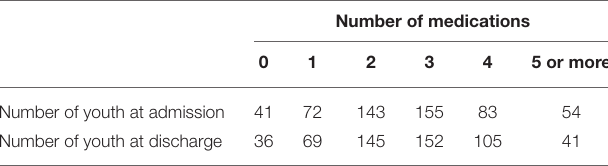
TABLE 3 | Changes in number of medications from admission to